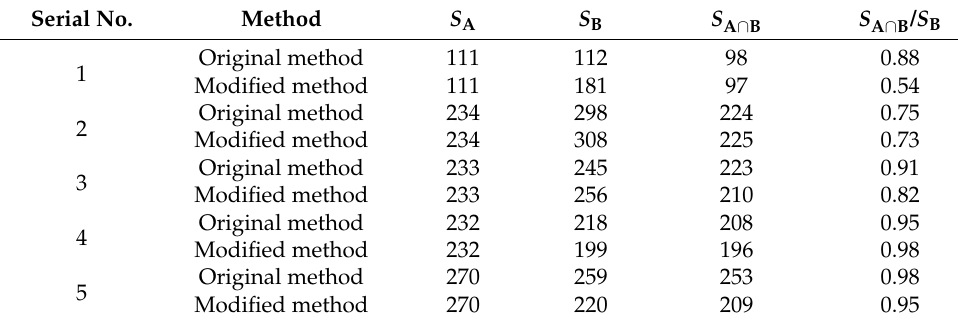
Table 15. Areas of SCP zone, SCC zone, and their intersected parts.